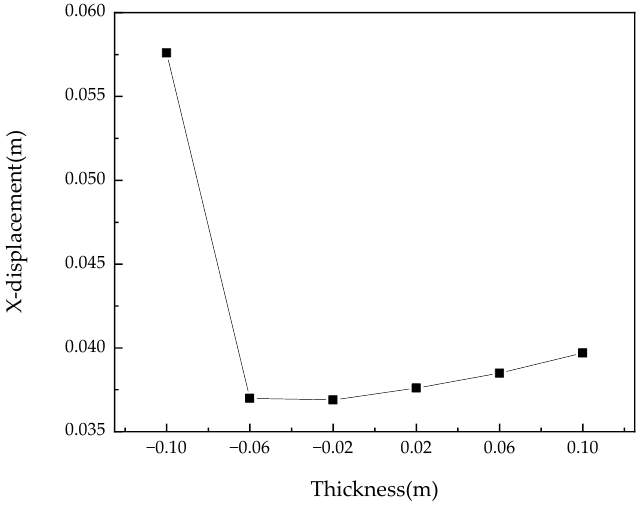
Figure 13. Displacement of the points along the X direction of the concave arc honeycomb.